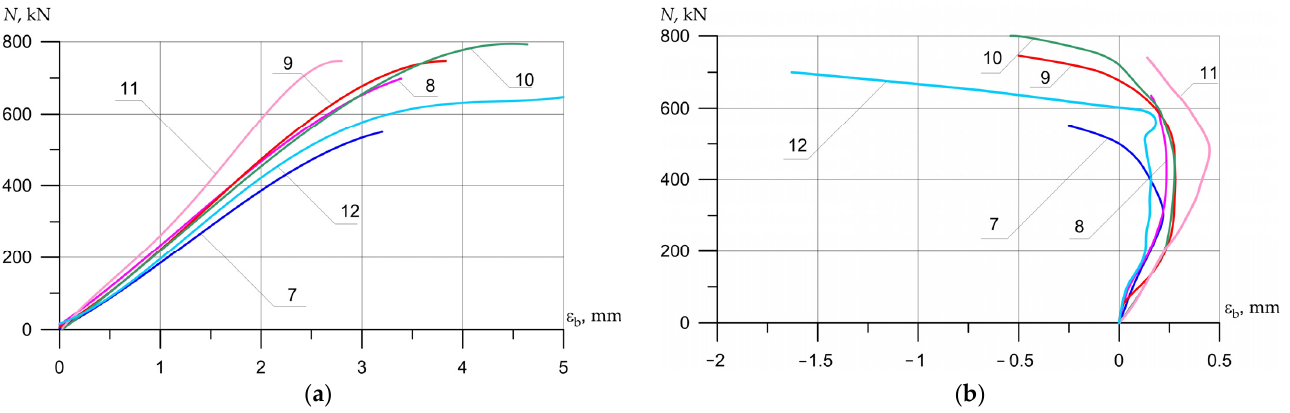
Figure 15. The average experimental values of the relative deformations of concrete in compression depending on the load and variants for composite reinforcement with axial eccentricity e 0 = 0. The numbers on the graphs correspond to the column numbers in Table 4.